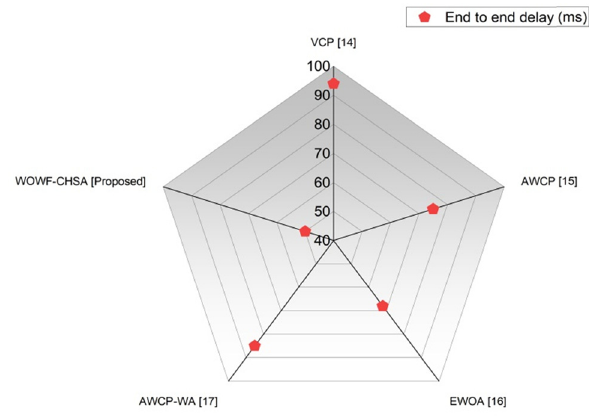
Figure 6: Results of proposed and existing methodologies ’ end - to - end delays.